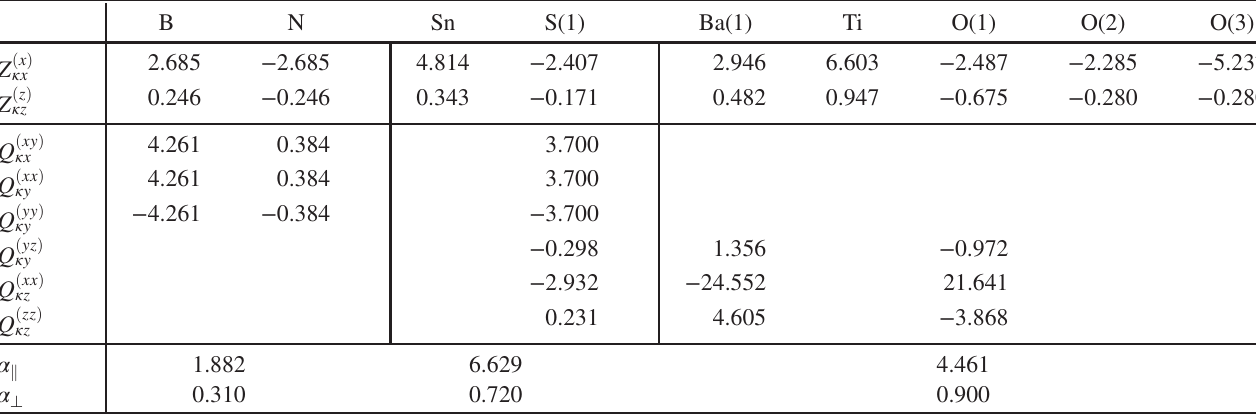
TABLE II. Cartesian components of dynamical dipole, quadrupole, and polarizability tensors (in the zone-boundary electrostatics). Atomic units are used; only linearly independent coefficients are shown. The numbering of the atoms refers to the convention in Fig. 3.